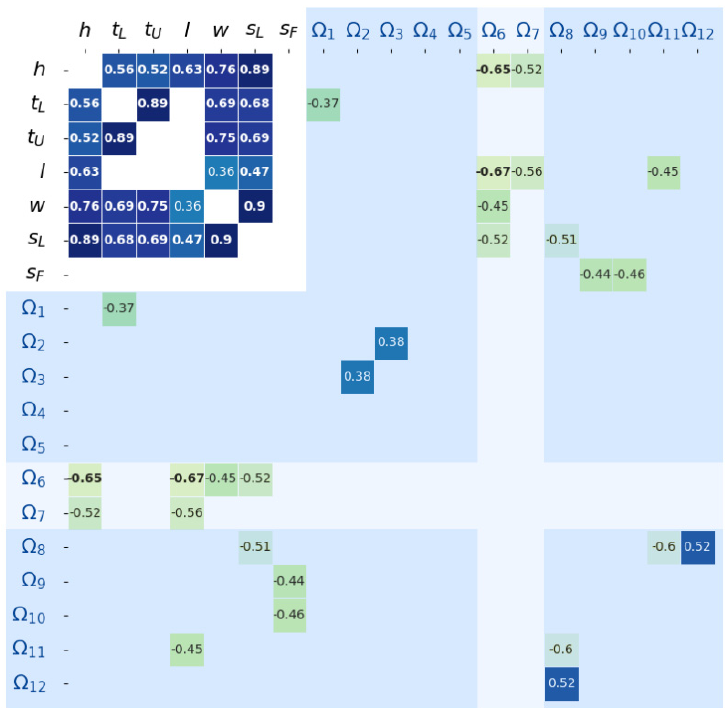
Figure 3. Spearman’s correlation heat map showing correlation coefficients of significances p < 0.05 and (bolded) p < 0.01.